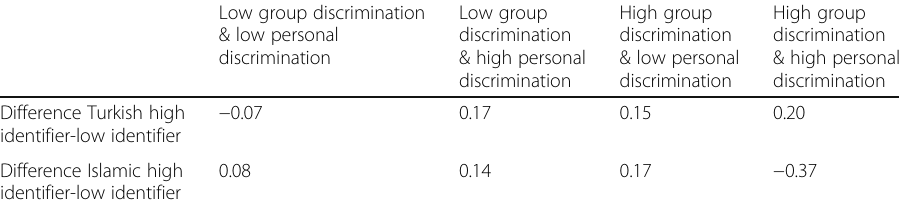
Table 6 Differences in the predicted probabilities between the highest identifiers and lowest identifiers, according to the lowest and highest scores on perceived group and personal